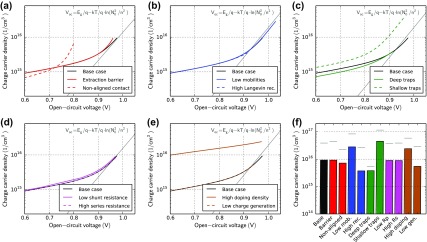
Charge extraction simulations for varied light intensity (and thus V
oc) for all cases defined in Table 1. The current is integrated over time according to Equation (17) to obtain the charge carrier density (the charge on the capacitance is subtracted). The light intensity is varied by five orders of magnitude. The grey-line is the theoretical V
oc for n = p in a zero-dimensional model. (f) Extracted charge carrier density at the highest light intensity. Grey lines represent the effective amount of photogenerated charge at open-circuit obtained from the simulated charge carrier profiles.